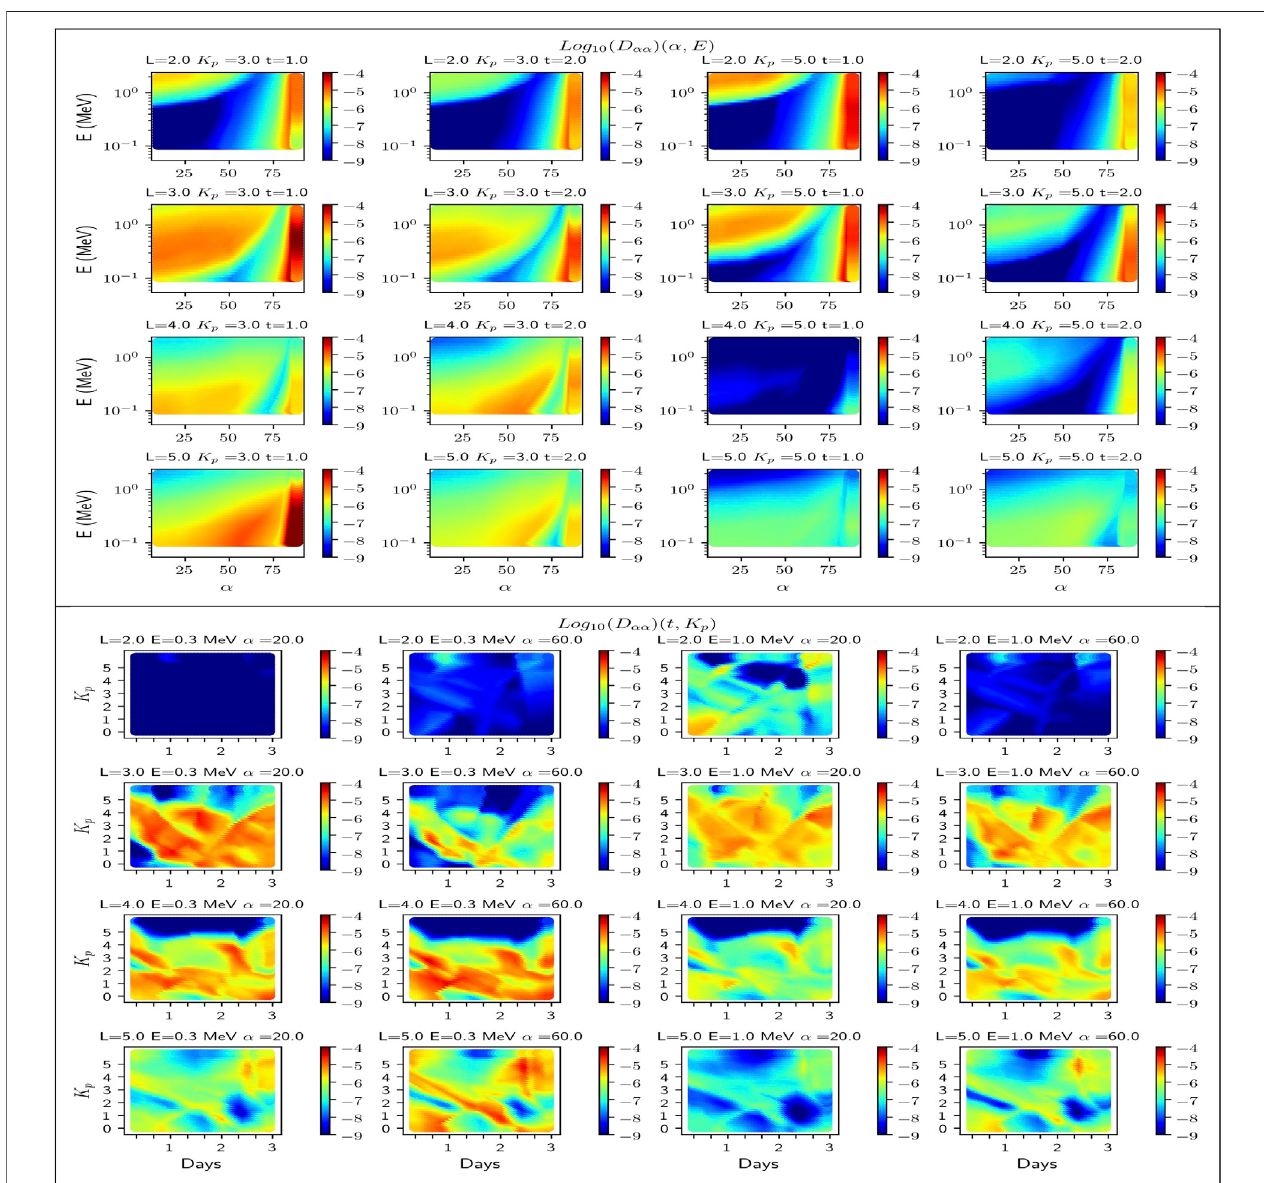
FIGURE 6 | The DNN model of ( D αα ) ( Log 10 of s − 1 ) in the (top) ( α , E ) plane at fi xed ( L , K p , t ) and (bottom) ( t , K p ) plane at fi xed ( L , E , α ).